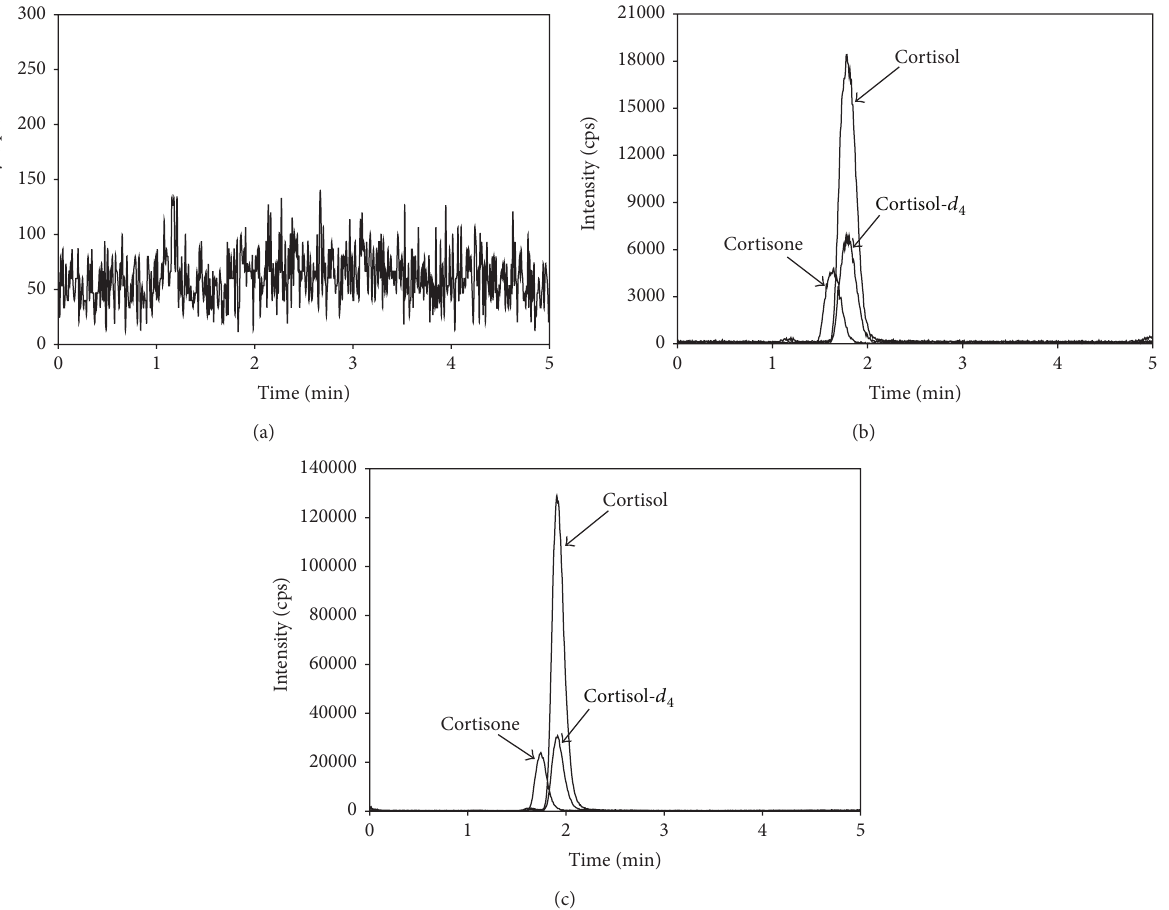
Figure 1: MRM chromatograms obtained by the present assay method. (a) Charcoal-stripped 5% FBS (blank). (b) A blank sample spiked with the standards at the concentrations of 10ng/mL of cortisol and 10ng/mL of cortisone and with 20 𝜇 L of working IS. (c) A healthy subject serum with the concentrations of 25 ng/mL of cortisol and 50 ng/mL of cortisone.